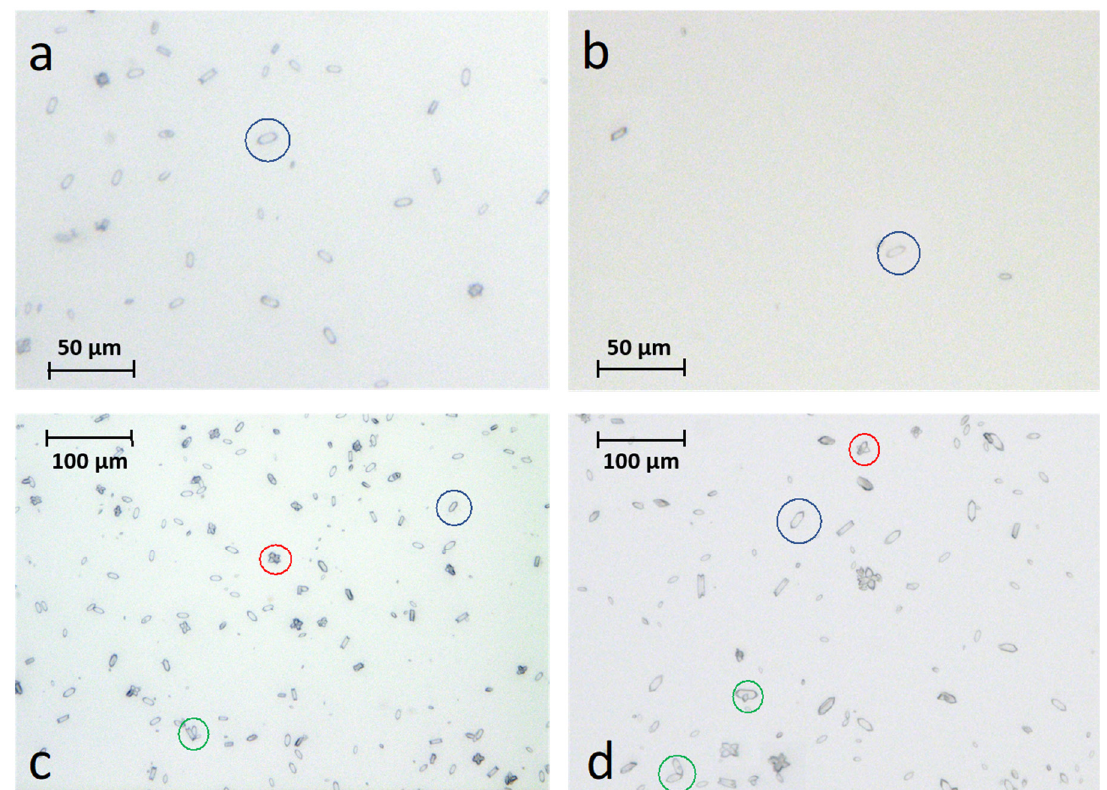
Figure 2. Micrographs of the CaOx suspensions obtained by mixing calcium chloride and sodium oxalate solution and prepared using OW1 ( a , c ) or OW2 ( b , d ) as solvent. Samples were left to rest for 1 h ( a , b ) or 24 h ( c , d ). The different crystal forms are highlighted with colored circles (blue circles for single crystals, green circles for contact twins, red circles for penetration